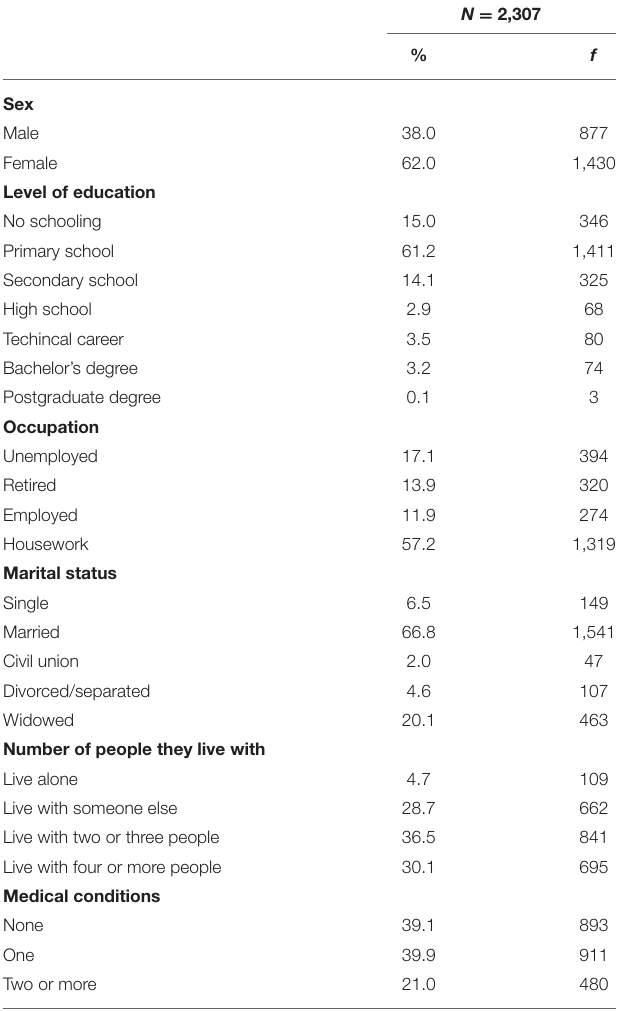
TABLE 1 | Distribution of participants by sociodemographic